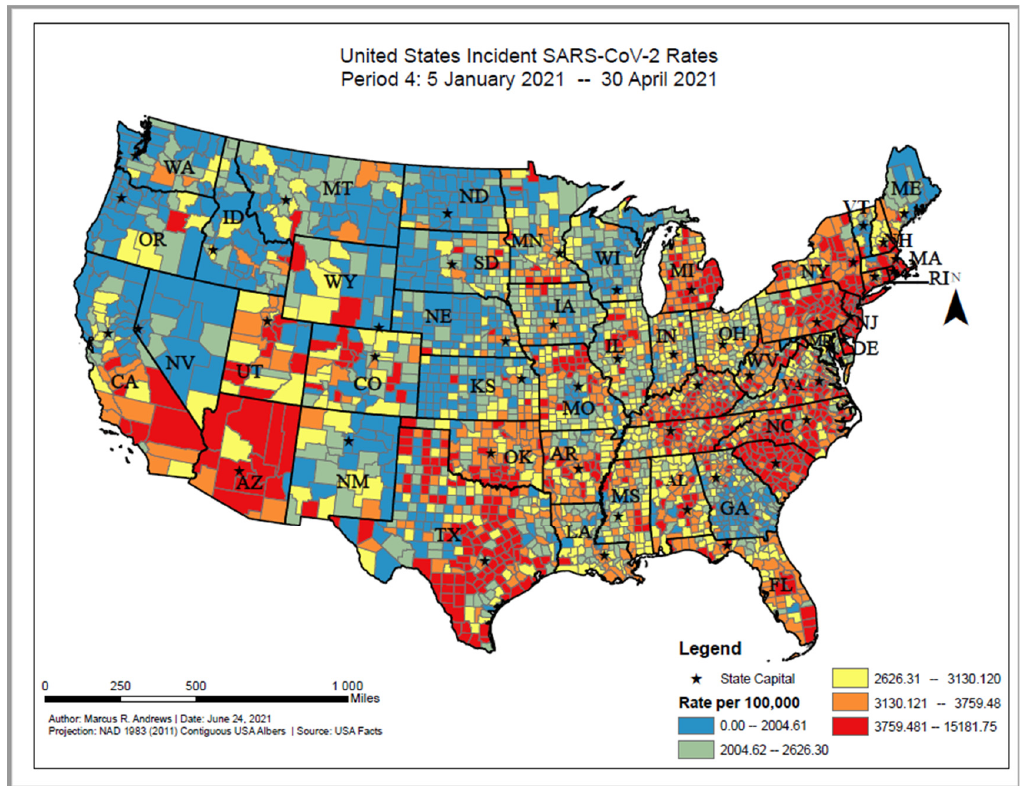
Figure 4. United States SARS-CoV-2 incident proportions, Period 4: 5 January 2021–30 April 2021.